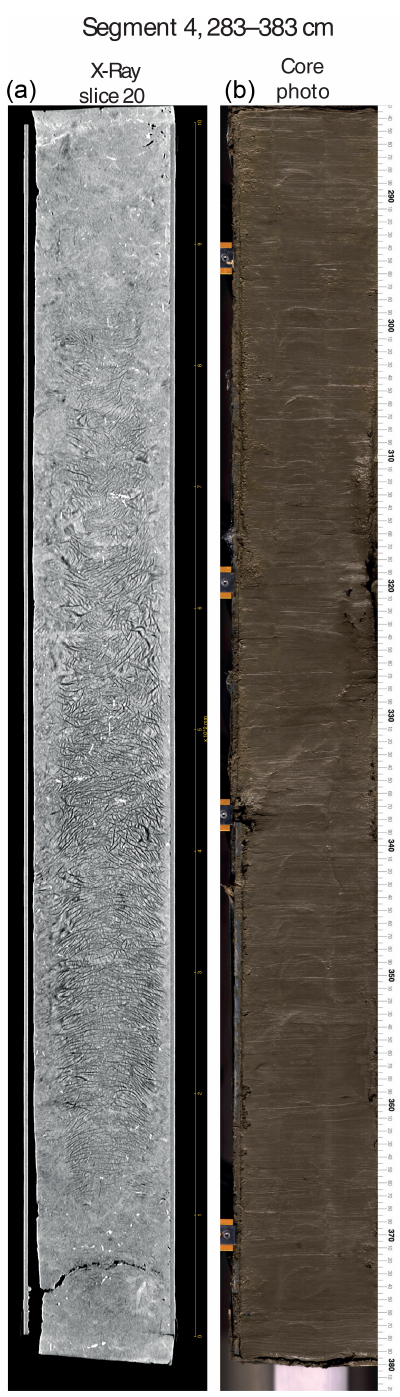
Figure D1. CT image (a) and photography (b) of segment 283–383cm of core M125-34-2.